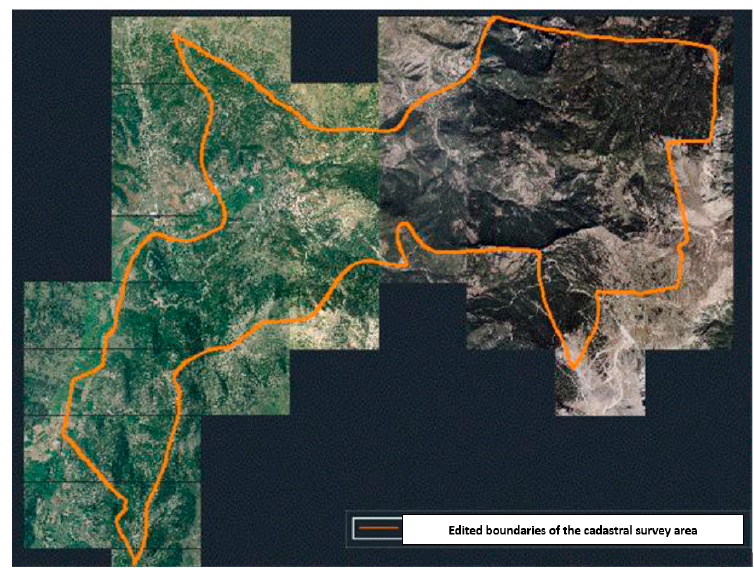
Figure 3. Edited boundaries of the cadastral survey area. Source: [35].